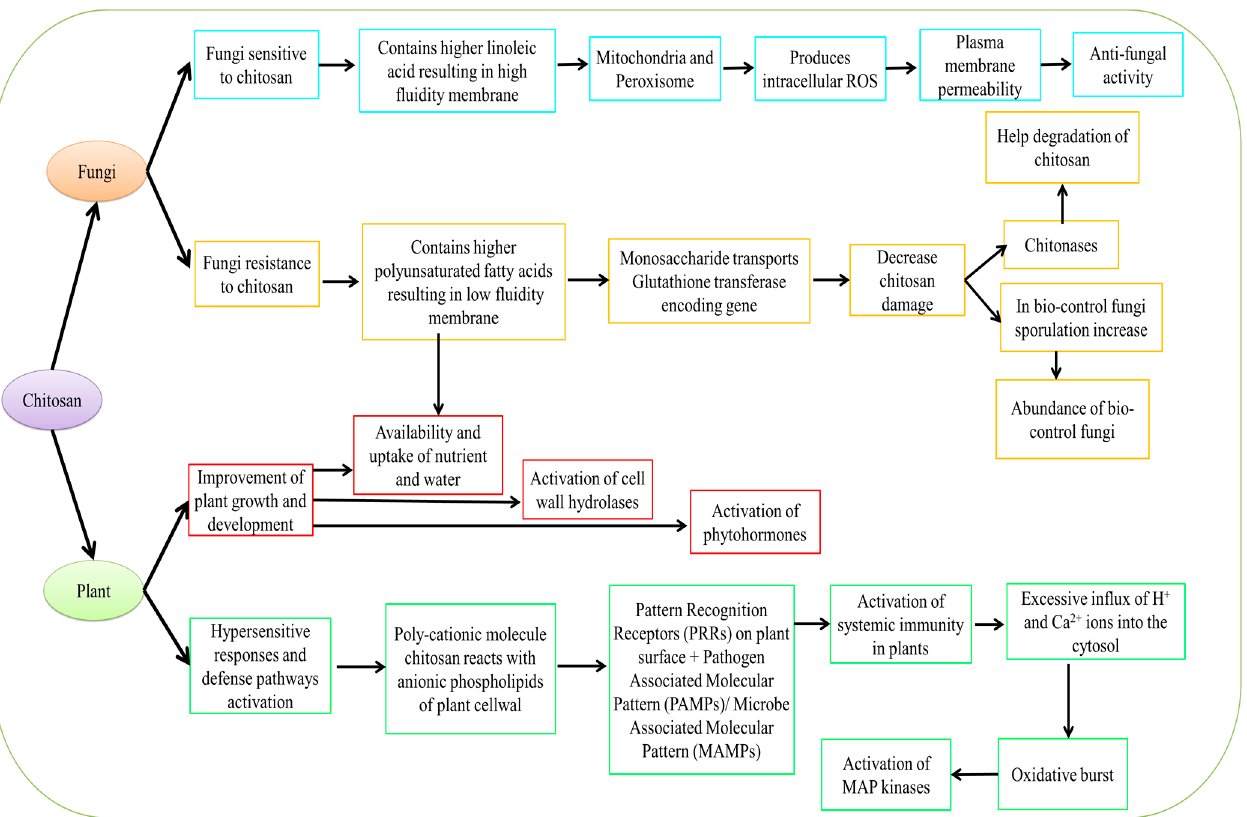
Figure 4. Mechanism of action of CS derived from plant and fungal sources.